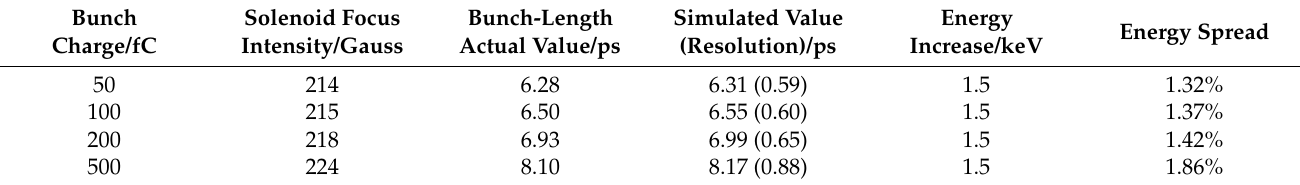
Table 3. The results of bunch length simulation with SCE under 50 kV deflecting